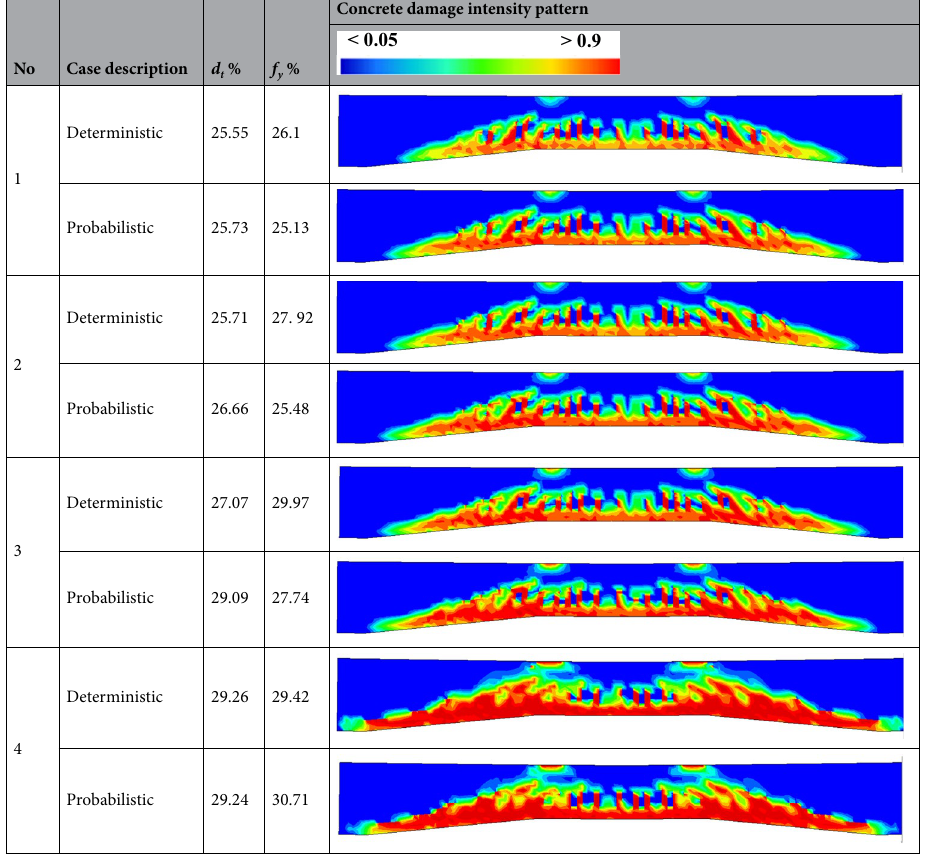
Table 2. Damage percentages inside